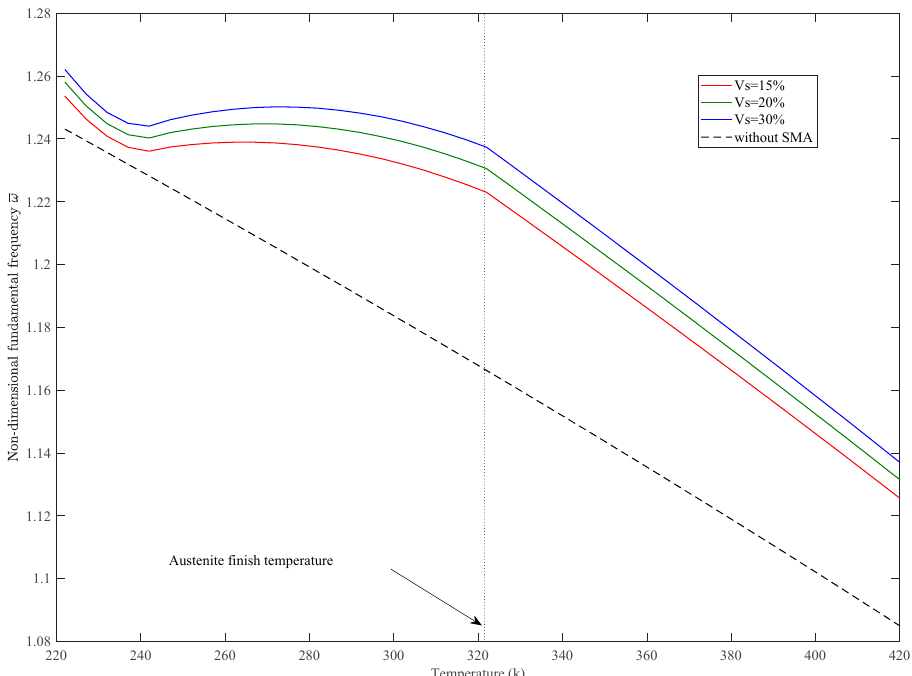
Figure 6. Variation of nondimensional fundamental frequency with temperature for different SMA volume fractions Vs, with [SMAHC/0/0/0]s, ε = 5%, CCCC boundary condition.